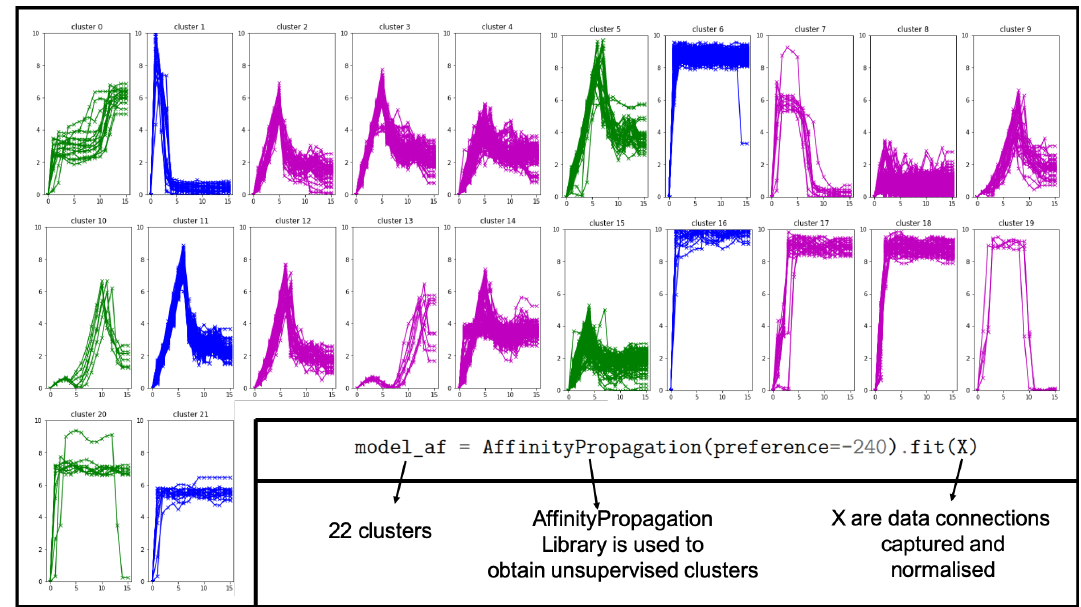
Figure 14. The result of using the unsupervised clustering method showed similar class groupings. They were not the definitive ones, because they had to be revised, modified, and validated. In facilities with many data, this first process is a good approximation to obtain an adequate clustering.